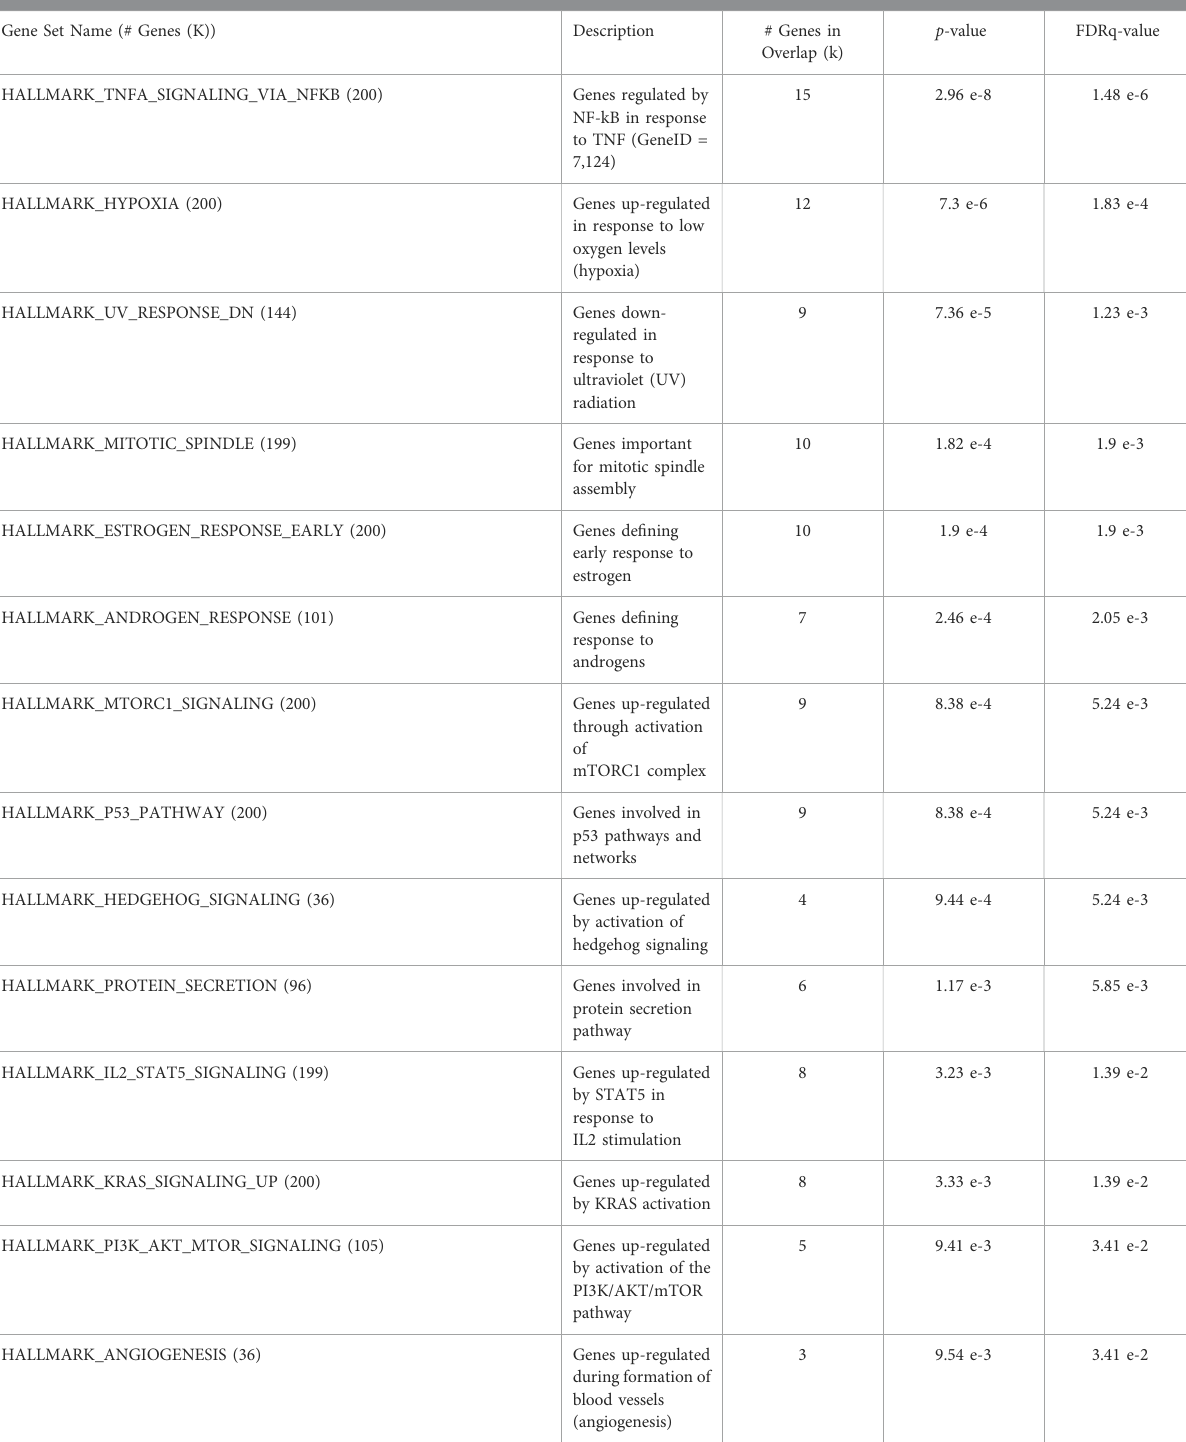
TABLE 4Pathwayenrichment analysisusing thetranscriptional pro fi leidenti fi edinthe cardiomyocytes exposed toCA or TPat1,000 μ MindividuallyA)or by both CA and TP B). For this analysis the Molecular Signatures Database (MSigDB v7.5.1) was utilized, and only the top enriched gene sets identi fi ed with the up-regulatedordown-regulated genes(FDR < 0.05,andfold changeof1.2 > )eitherforCAor TP,individuallyorbybothCA andTP(commongenesaffectedin the same directions) are shown in the tables. Regulated pathways by up-regulated genes by both CA and TP at 1,000 μ M in cardiomyocytes Gene Set Name (# Genes